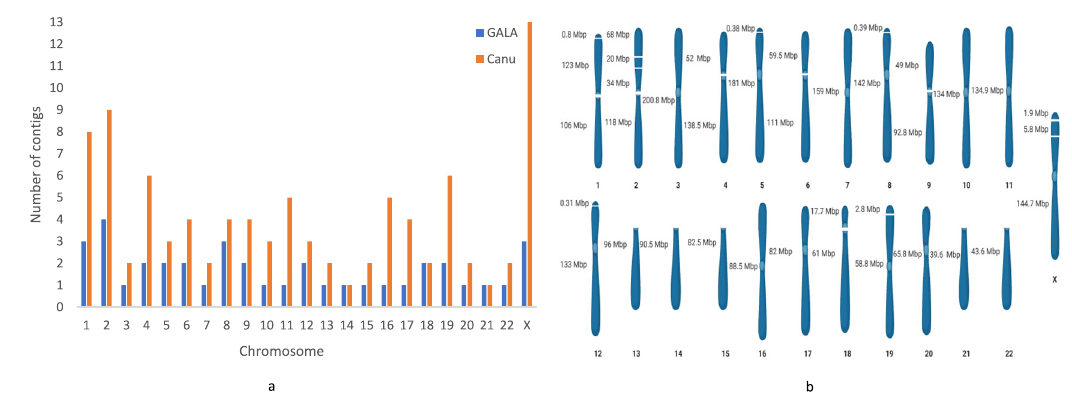
Fig. 4 | Human genome assembly by GALA. a Comparison of the number of contigs in assemblies by Canu and GALA. b A cartoon presentation of each chromosome assembled by GALA with the lengths of contigs labelled, created with